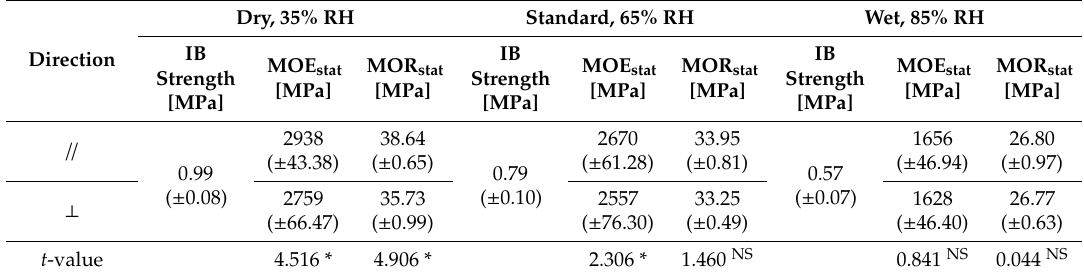
Table 4. Static bending properties and internal bond (IB) strength of Medite Tricoya ® MDF samples. Values in parentheses are the standard